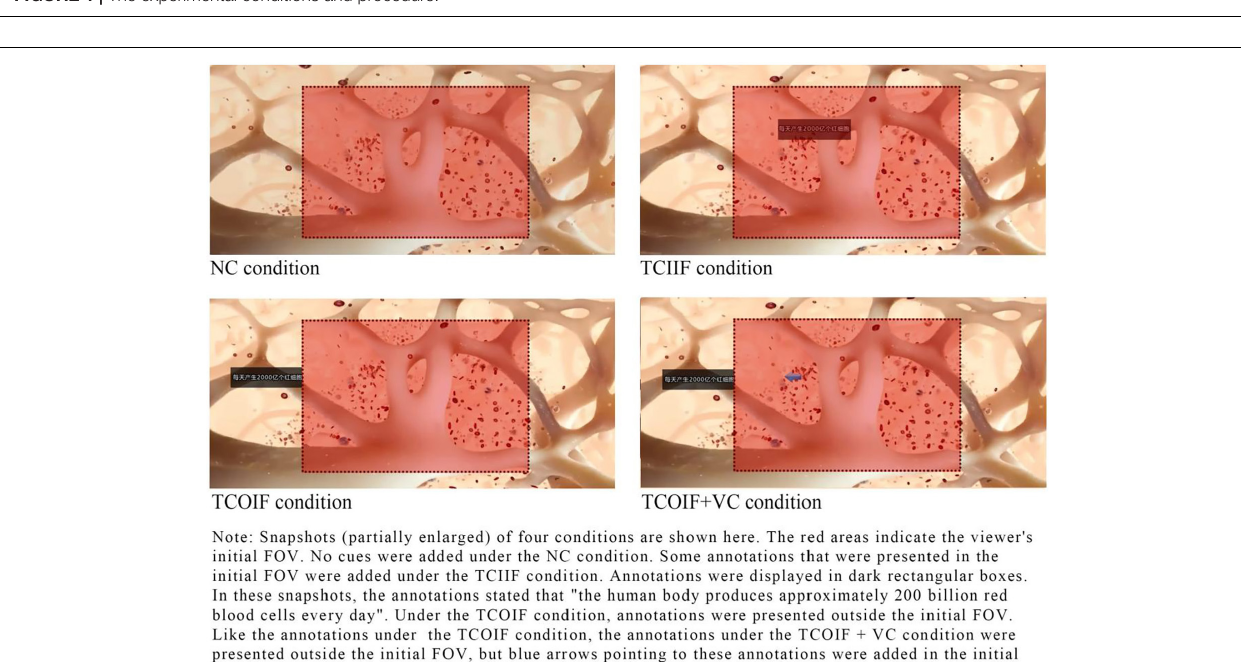
FIGURE 1 | The experimental conditions and procedure.